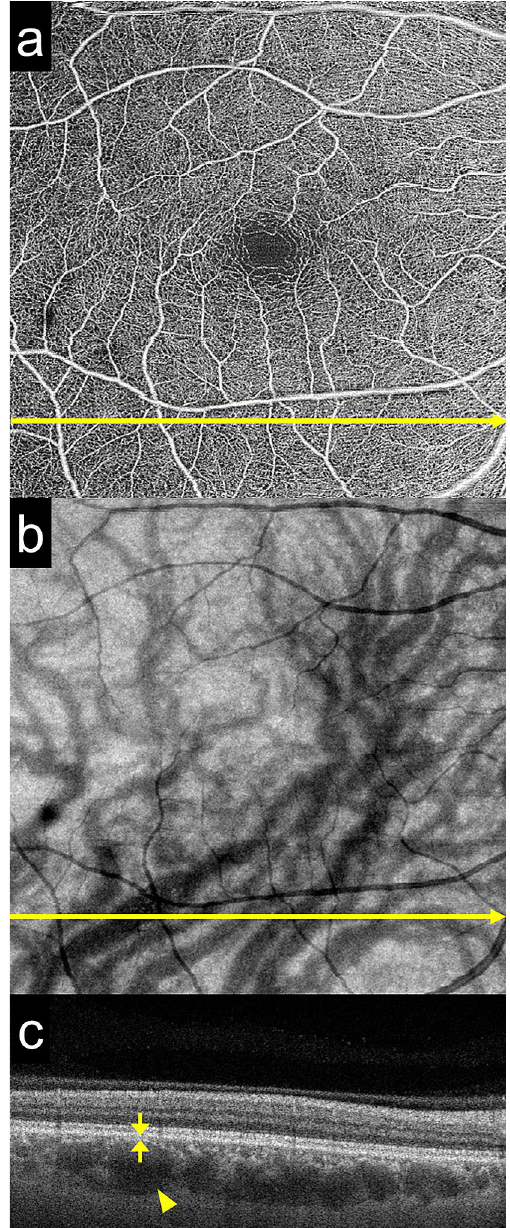
Figure 1. The method used to identify thick choroidal vessels (pachyvessels) near the retinal pigment epithelium (RPE). ( a ) A 6 × 6 mm swept- source optical coherence tomography (SS-OCT) image of the retinal slab. The yellow arrow indicates the location of the scan ( c ). ( b ) An SS-OCT image of the choroidal slab. A thick choroidal vessel is seen in the inferior area. The yellow arrow indicates the location of the scan ( c ). ( c ) An SS-OCT cross-sectional image taken at the location of yellow arrow in ( a ) and ( b ). Pachyvessels were identified by checking all 500 cross-sectional OCT images and en face SS-OCT images of the choroidal slab ( b ) using built-in software. Note that the thick choroidal vessel (vertical diameter > 300 µm, arrow head) is seen near the RPE, with the distance to the RPE being < 50 µm